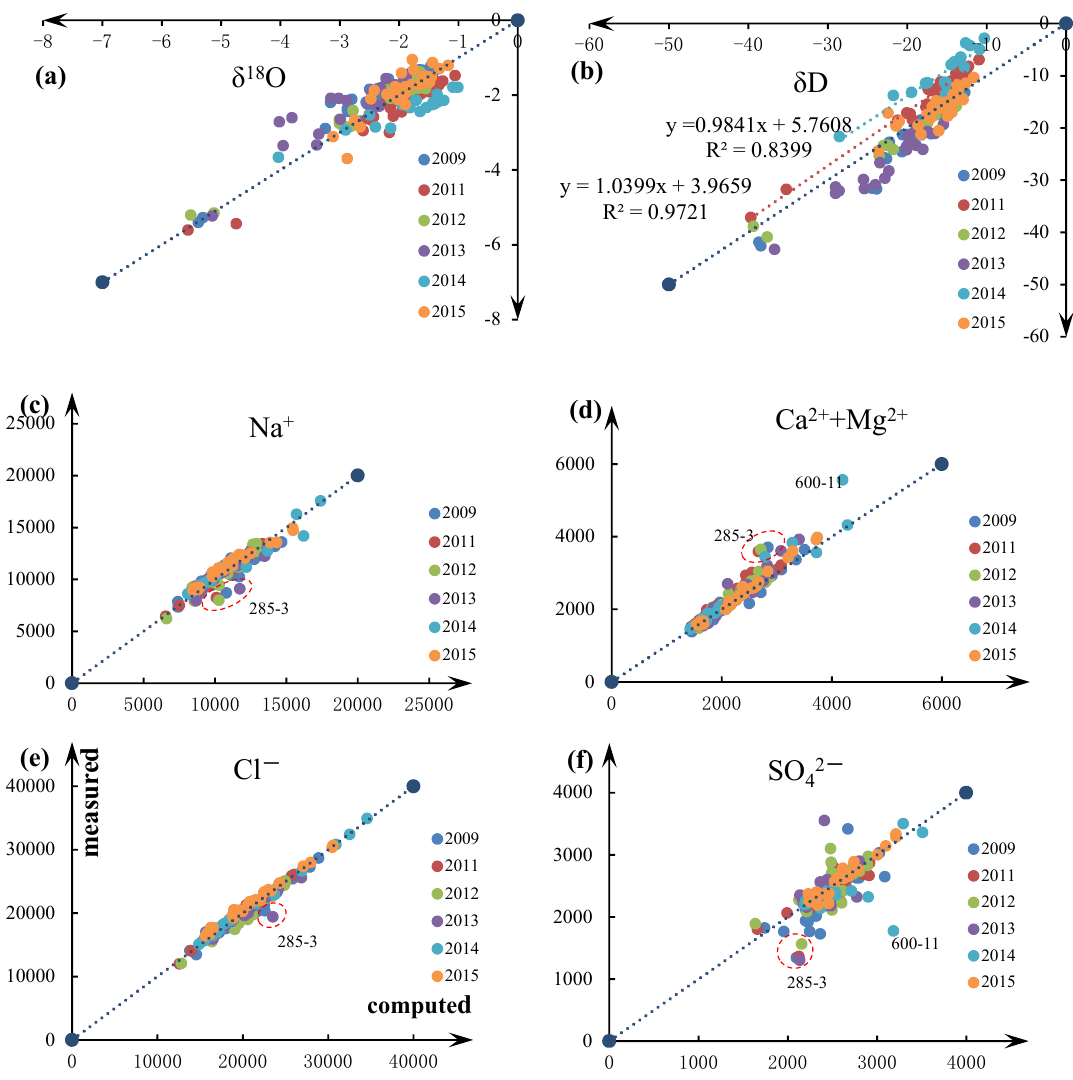
Figure 7. Relationship between computed concentrations ( x -axis) versus measured concentrations ( y -axis). Samples were collected from 2009 to 2015. (( a – f ) is δ 18 O, δ D, Na + , Ca 2 + + Mg 2 + , Cl − and SO4 2 − , respectively.)